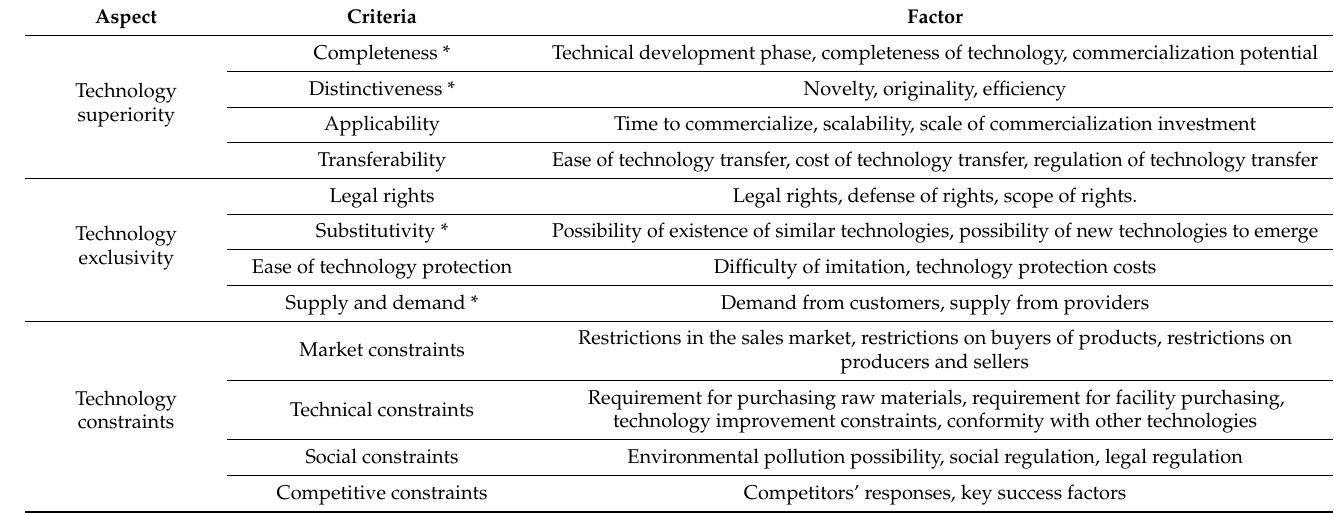
Table 2. Aspects of technology valuation